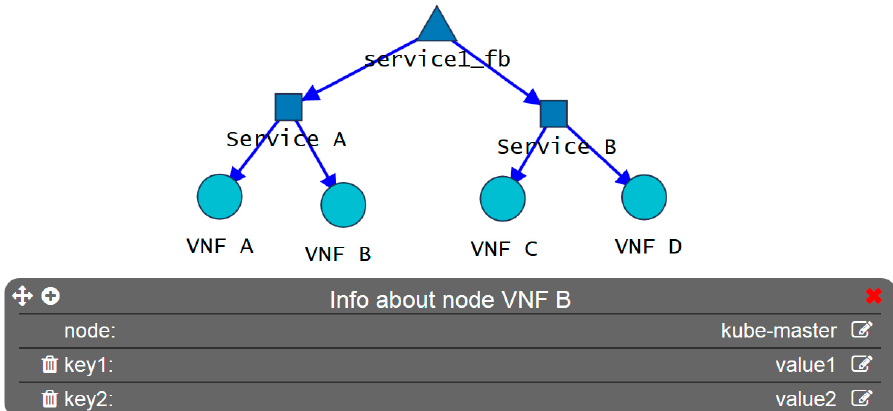
Figure 4. Example of RFB graph from the RDCL 3D tool.